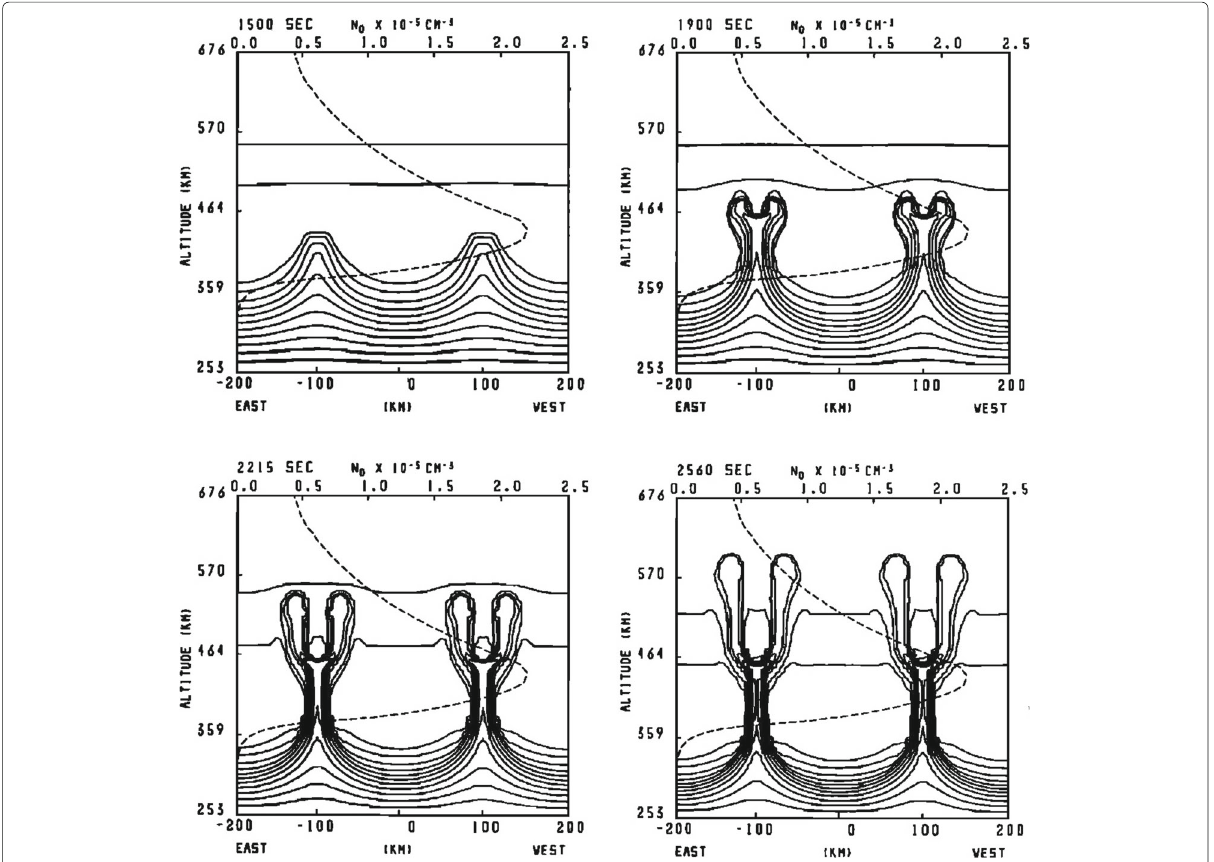
Fig. 2 Bifurcating EPBs modeled with a three-layer model. Reproduced from Zalesak et al.